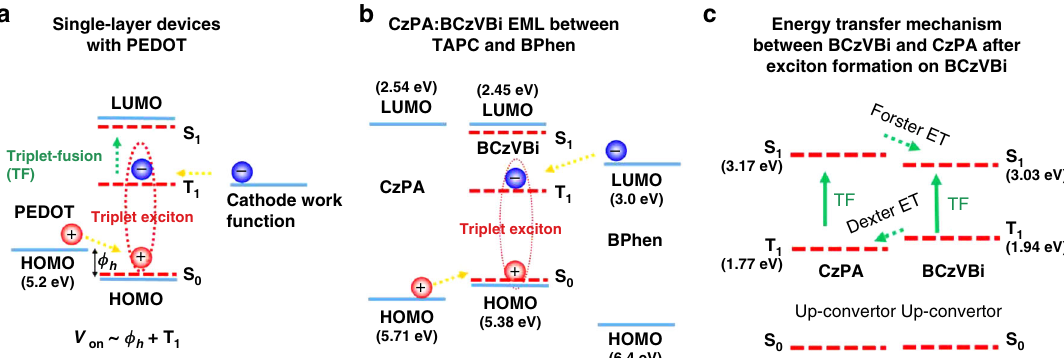
Fig. 5 Direct triplet exciton formation mechanisms. a Direct triplet exciton formation in single-layer devices with the structure ITO/PEDOT/Emitter/ Cathode. b Direct triplet exciton formation on BCzVBi molecule, in CzPA:BCzVBi EML placed between TAPC and BPhen as HTL and ETL, respectively.